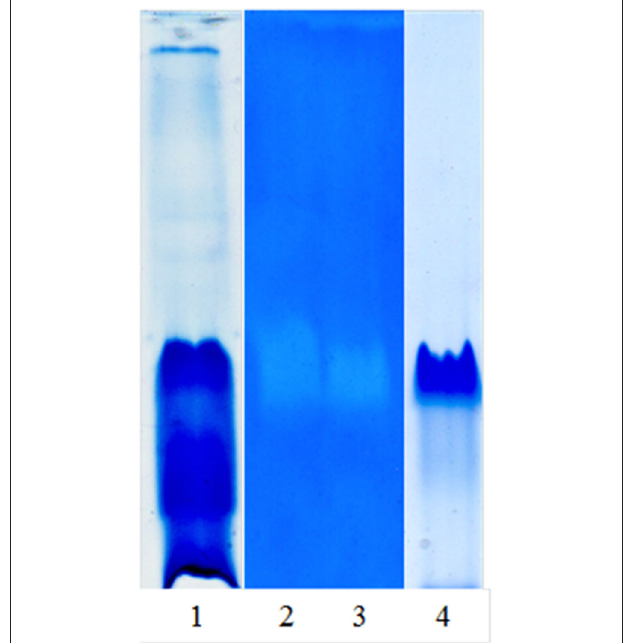
FIGURE 1 | Native PAGE and zymogram of partially purified proteolytic extract (RAP) of Solanum granuloso-leprosum and granulosain I. Lane 1, RAP, stained gel with Coomassie brilliant blue-R-250; Lane 2, zymogram of RAP; Lane 3, zymogram of granulosain I; Lane 4, granulosain I, stained gel with Coomassie brilliant